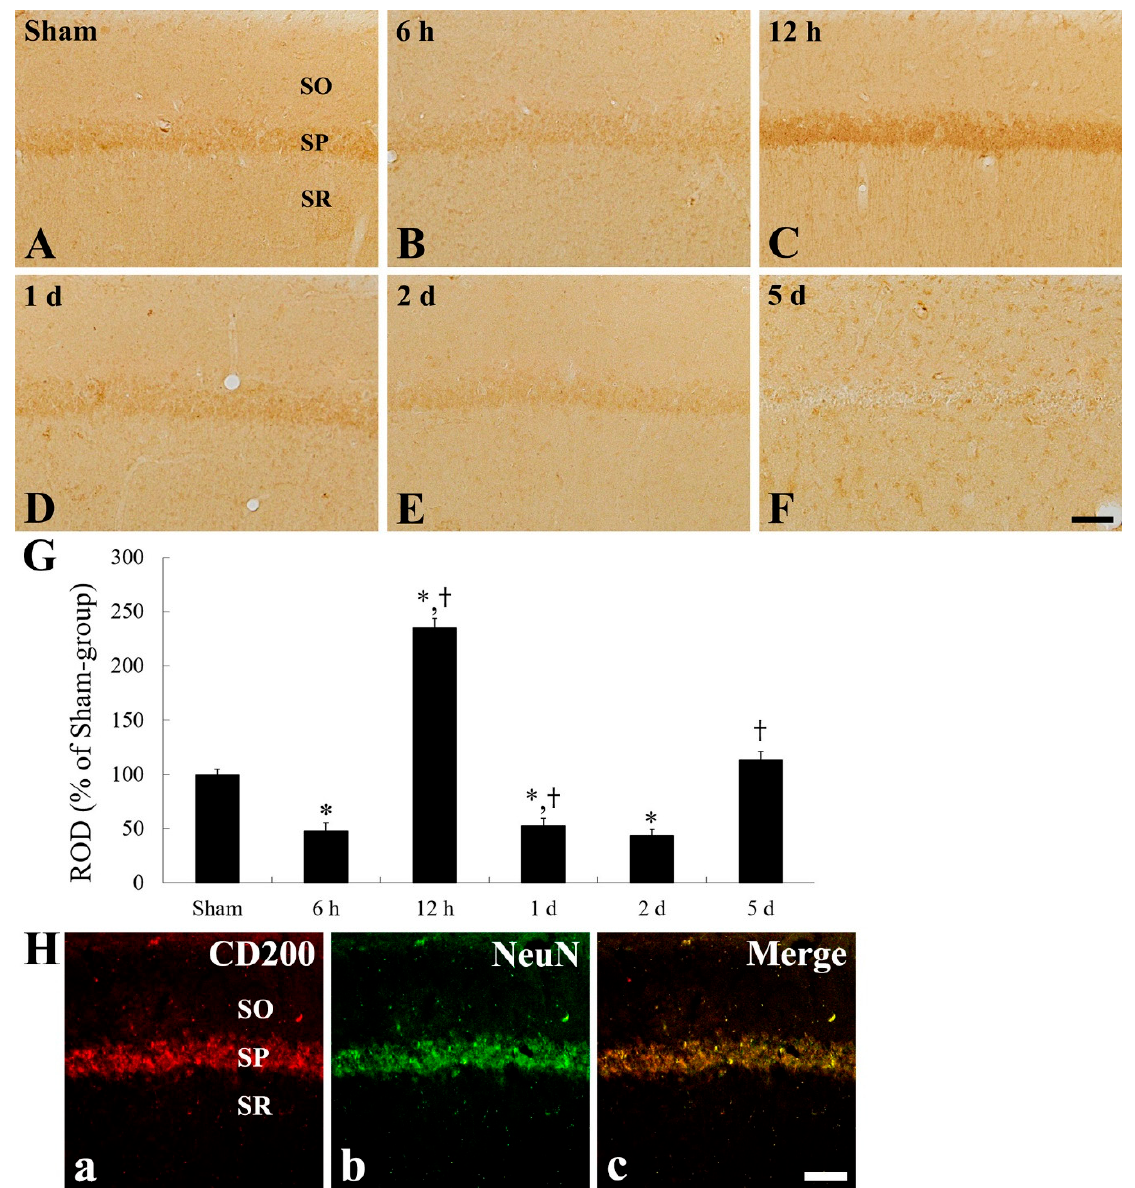
Figure 4. CD200 immunohistochemistry in the CA1 field of the sham group ( A ) and ischemia group ( B – F ). CD200 immunoreactivity is significantly decreased in the SP (asterisk) at 6 h after tFI, increased transiently (asterisk) at 12 h after tFI, and decreased again 1 day after tFI. At 5 days after tFI, CD200 immunoreactivity in the SP is hardly shown, but dramatically and newly shown in non-pyramidal cells (arrows) in the SO and SR. Scale bar = 50 µm. ( G ) ROD as % of CD200-immunoreactive structures in the CA1 field ( n = 7 at each time; * p < 0.05, significantly different from sham group; † p < 0.05, significantly different from pre-time point group). ( H ) Double immunofluorescence staining for CD200 (red, ( Ha )), NeuN (green, ( Hb )), and merged images ( Hc ) in the CA1 field of the ischemia group at 12 h after tFI. Bars in “G” indicate the means ± SEM.